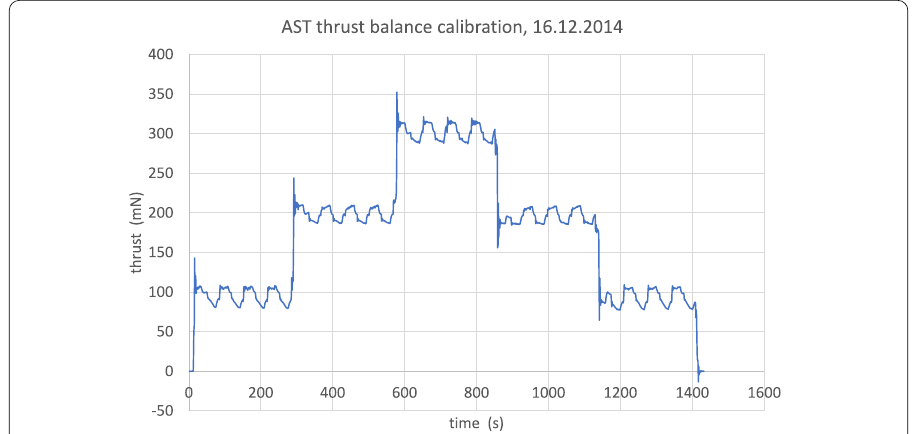
Figure 5 Calibration procedure of the AST thrust balance. Three weight are used, increasing and decreasing the force, and performing four forth and back moves at each calibration